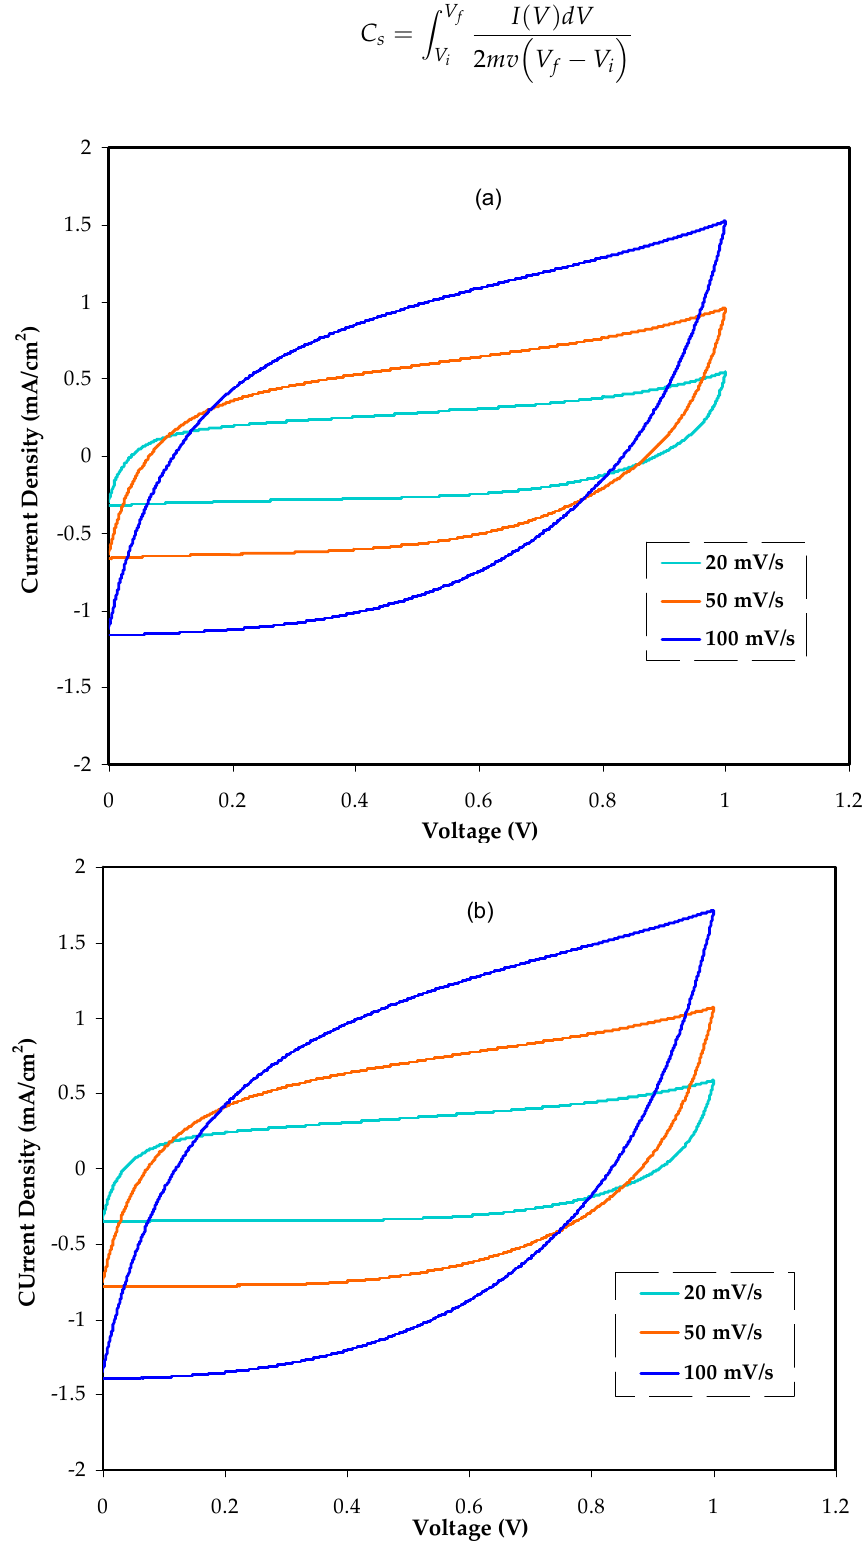
Figure 13. The CV patterns of the designed EDLC for the ( a ) BGNN5 and ( b ) BGNN4 systems. Table 4. C s at differentscan rates for the BGNN4 system (40 wt.% glycerol) and the BGNN5 system (50 wt.% glycerol).